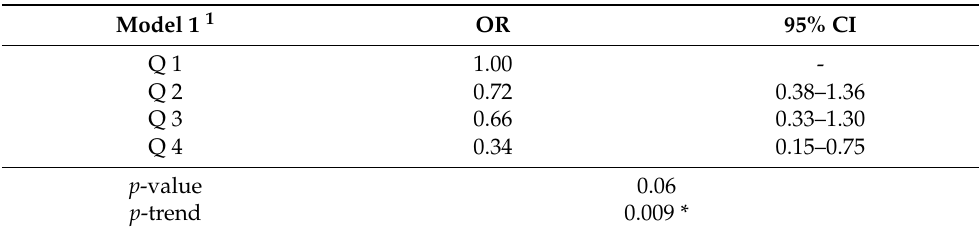
Table 4. Odds ratios and 95% confidence intervals between FV intake and CRC risk (N = 526; cases: (N = 118), controls (N =